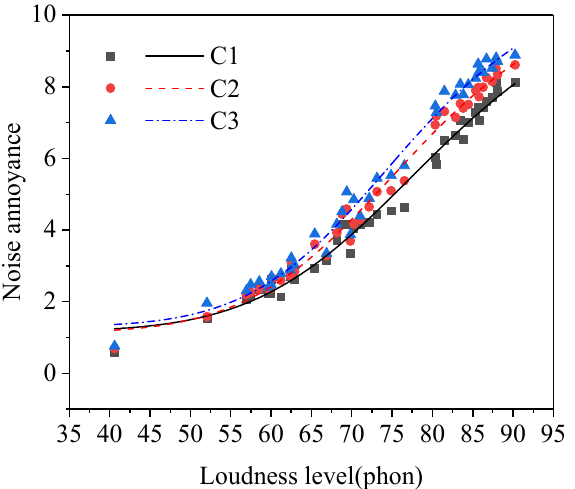
Figure 4. Noise annoyance of three groups of subjects with different education levels (subgroups C1–C3). (subgroups C1–C3).